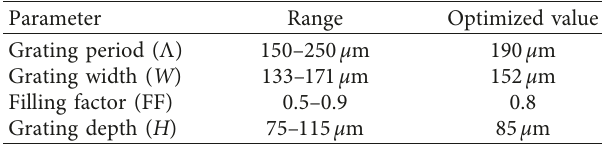
Table 1: The optimized grating parameters used in this study. Parameter